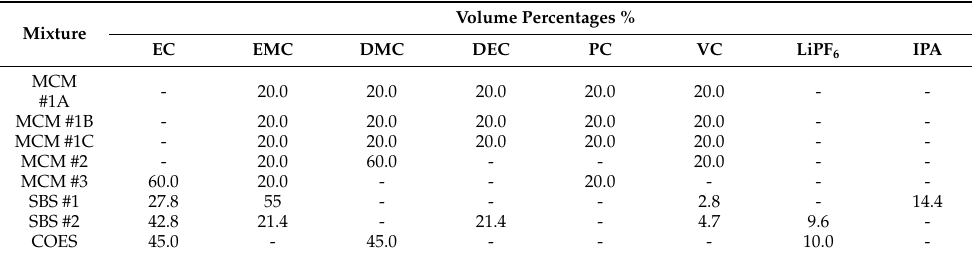
Table 1. Composition of various mixtures analyzed by GC × GC/FID and GC × GC/EI TOF MS